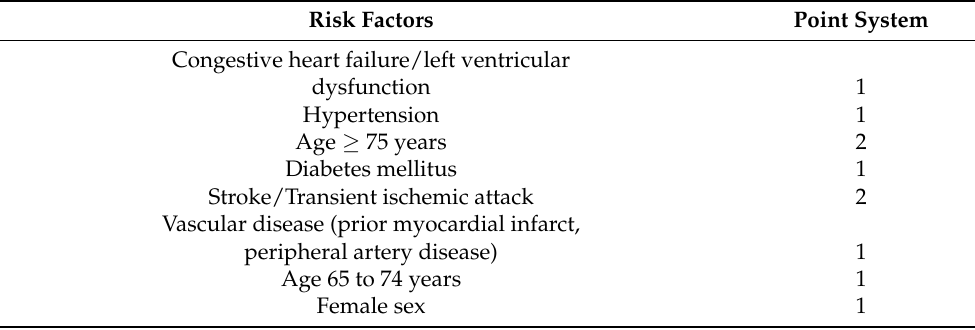
Table 2. Stratification of Risk of Stroke and Thromboembolism in Nonvalvular Atrial Fibrillation by the CHA 2 DS 2 -VASc Score.